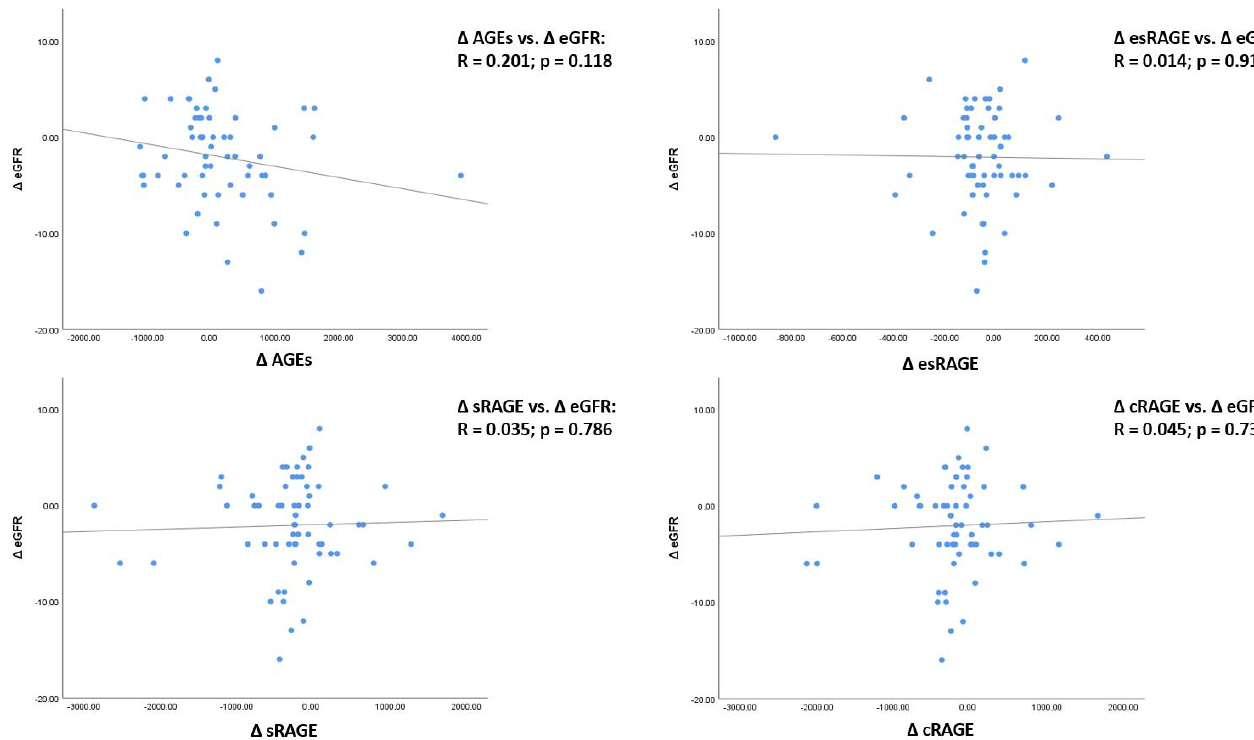
Figure 3. Linear regression analyses between the differences (basal–FU) of advanced glycation end products (ΔAGEs), soluble receptor for AGEs (ΔsRAGE) and its isoforms (ΔesRAGE and ΔcRAGE) and eGFR (ΔeGFR). Δ: difference; BS: baseline; FU: follow-up; AGEs: advanced glycation end products; sRAGE: soluble receptor for advanced glycation end products receptor; esRAGE: spliced soluble receptor for AGE; cRAGE: cleaved receptor for AGE.